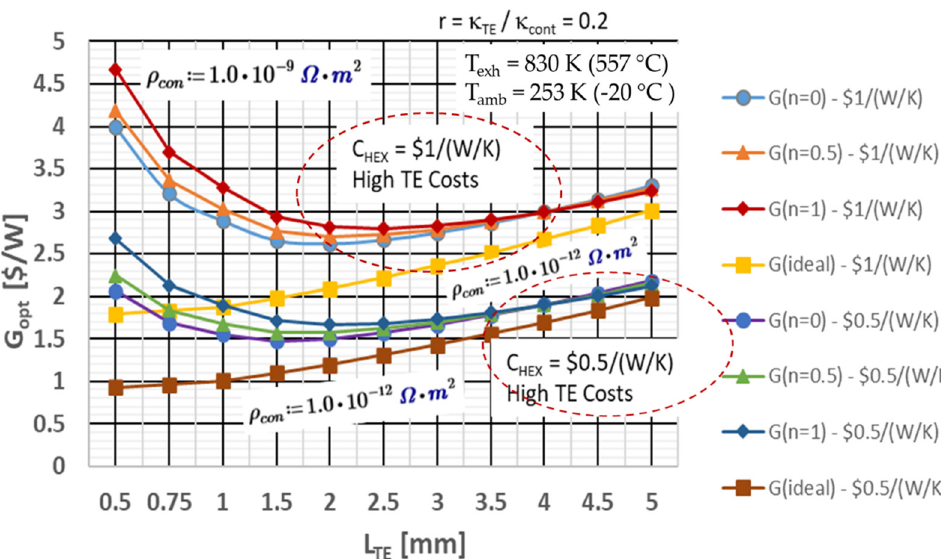
Figure 20. Electrical and Thermal Contact Interface Effects on Overall TEG Cost Minimization for Various Heat Exchanger Cost Parameters and Cost Sensitivities to TE Manufacturing Costs (r = 0.2).